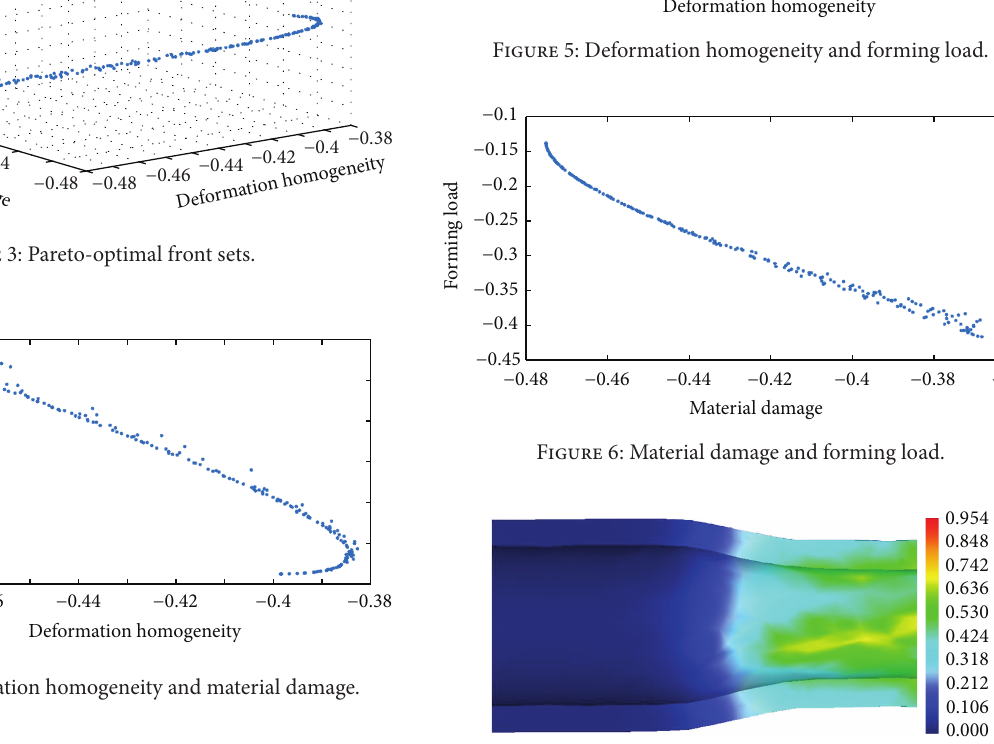
Figure 7: Contours of equivalent strain.